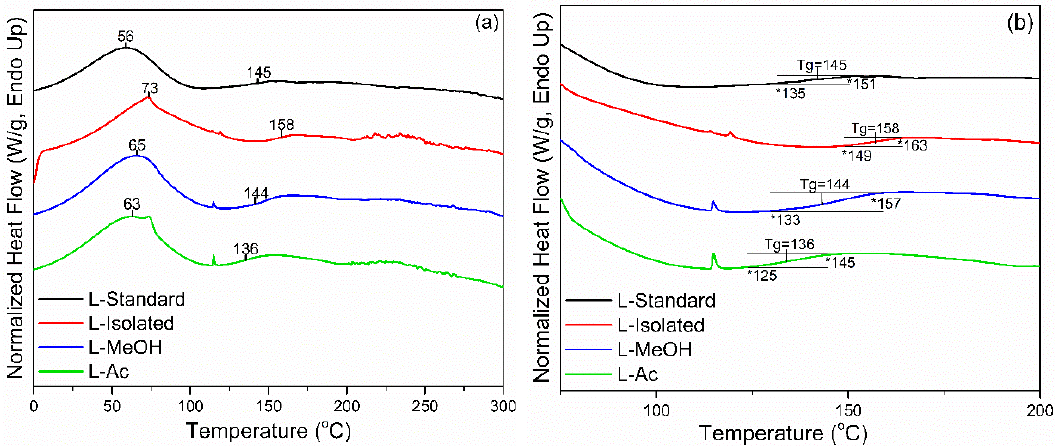
Figure 4. DSC thermograms of lignin before and after fractionation: ( a ) full thermogram, ( b ) enlarged thermogram.